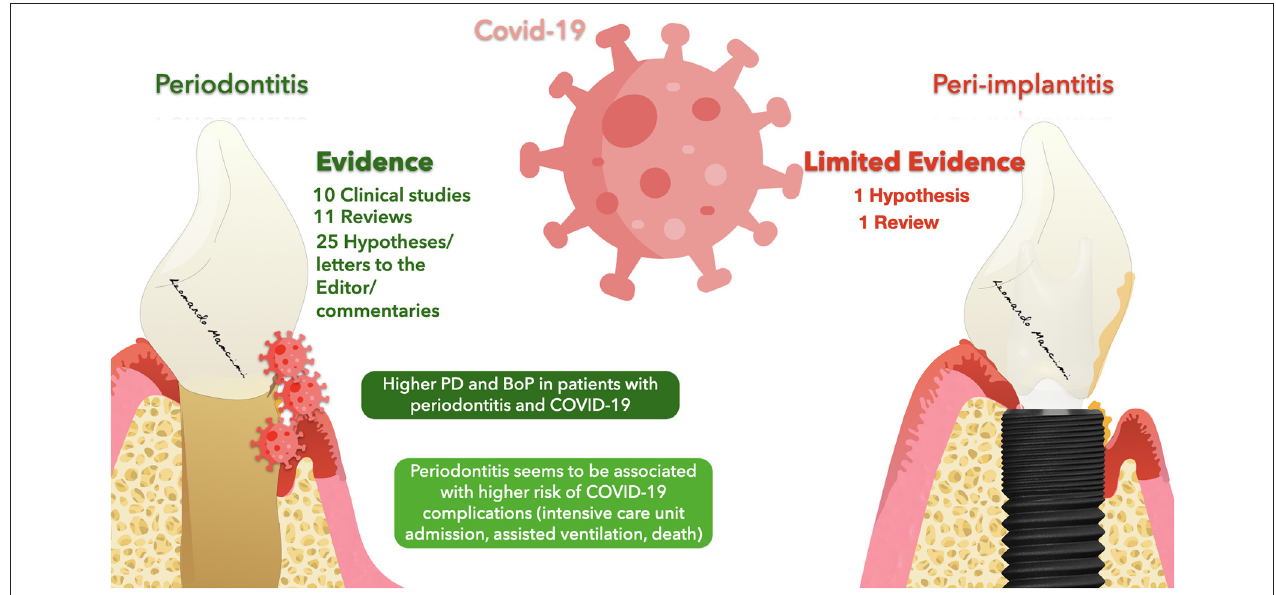
FIGURE 2 | Representation of evidence regarding a possible correlation between Periodontitis/Peri-implantitis and